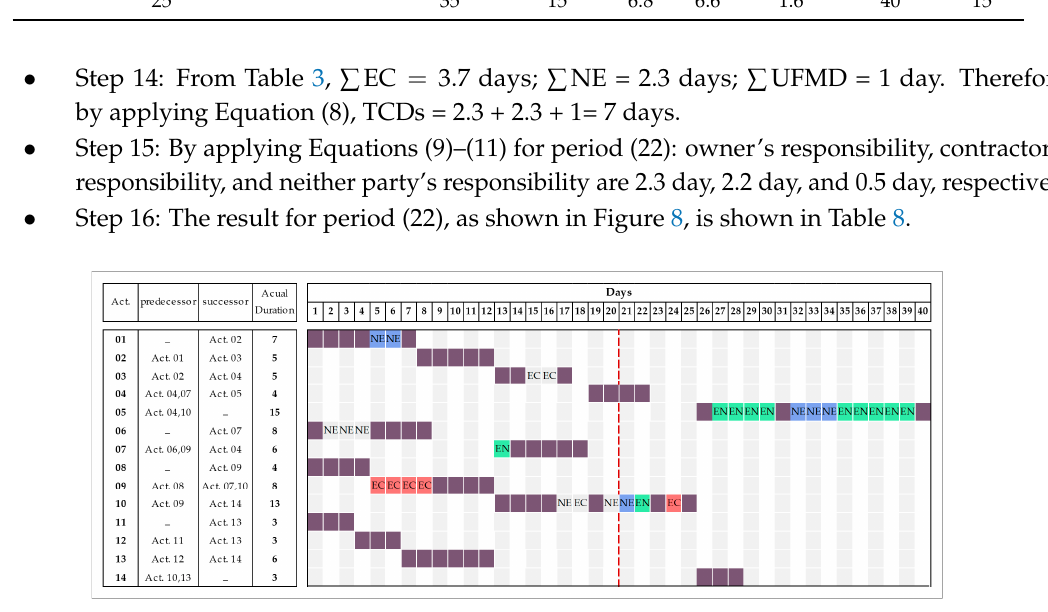
Table 7. The analysis results for period (35–39).